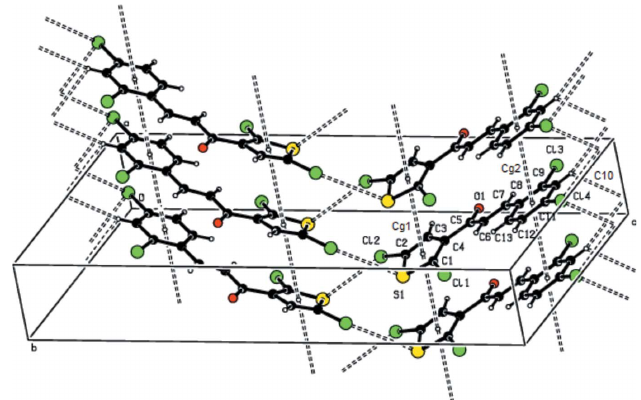
Figure 1 The molecular structure of the title compound, showing the atom labelling and displacement ellipsoids drawn at the 50% probability level. The two intramolecular C—H (cid:3)(cid:3)(cid:3) Cl contacts (see Table1) are shown as dashed lines.